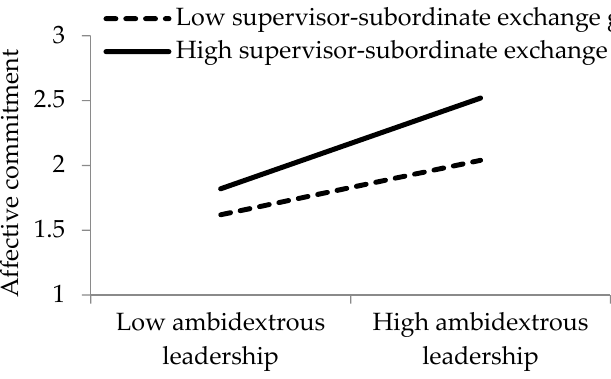
Figure 4. Influence of ambidextrous leadership on affective commitment under different supervisor– subordinate exchange guanxi scenarios.